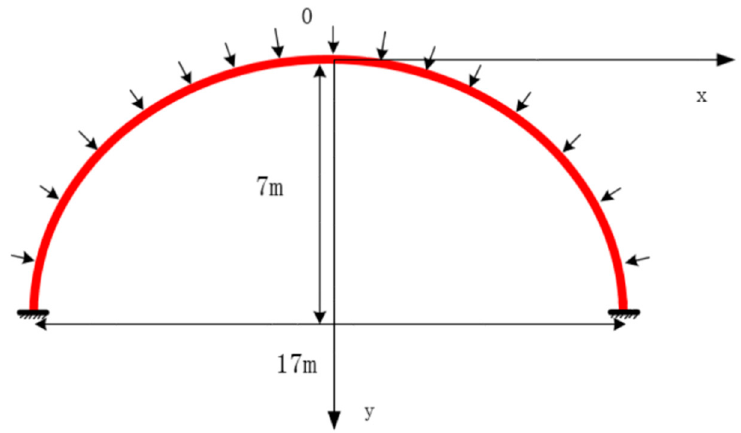
Figure 2. Distribution of adjustment load position.